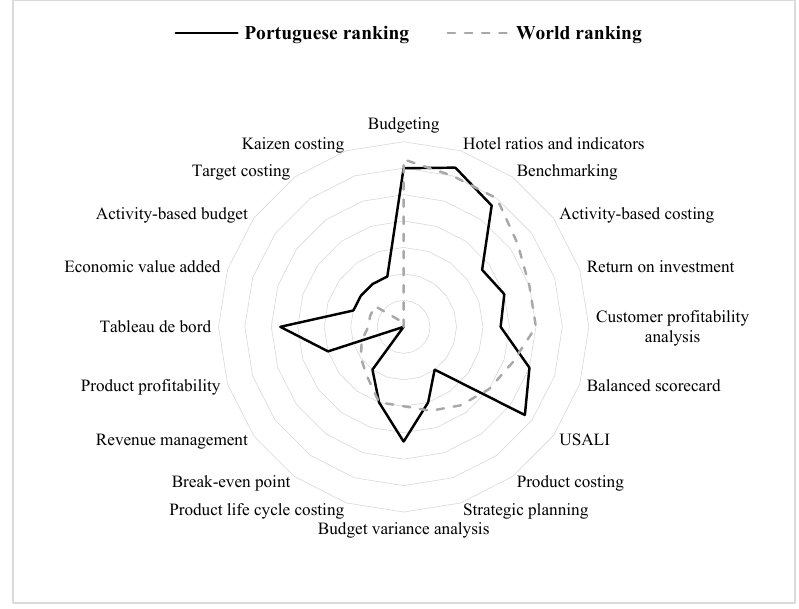
Figure 11. Portuguese ranking vs. world ranking on hospitality MA practices.